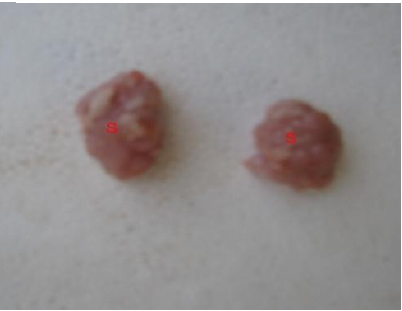
Figure 2: The accessory sex gland, vesicular gland (S), Ampulla of ductus deferens (A) and bulbourethral gland (B) in ram.